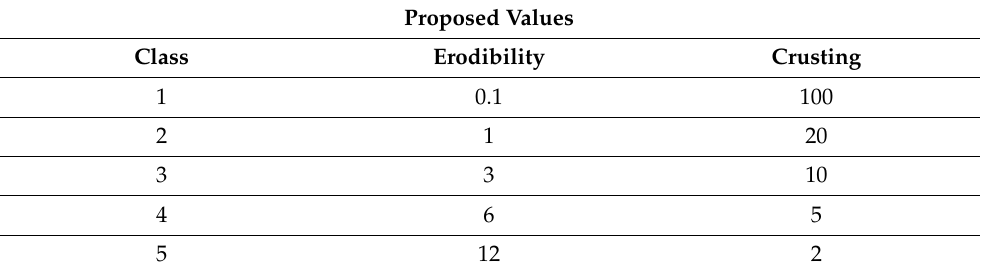
Table A3. Erodibility and crusting proposed values [29].